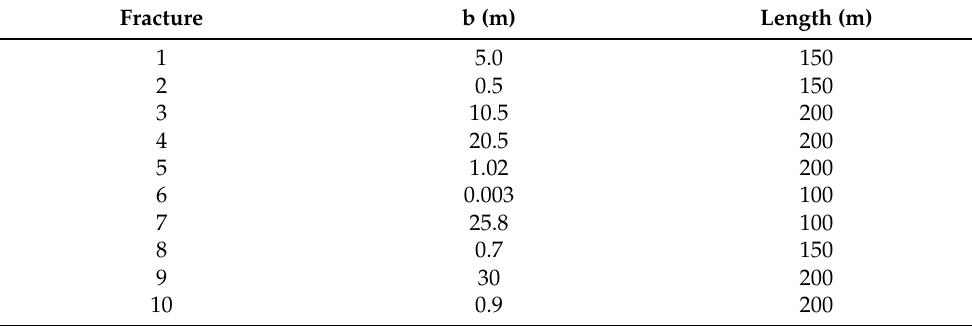
Figure 12. 50 fractures of the same hydraulic conductivities with parameters given in Table 6. Table 5. Described parameters for Figure